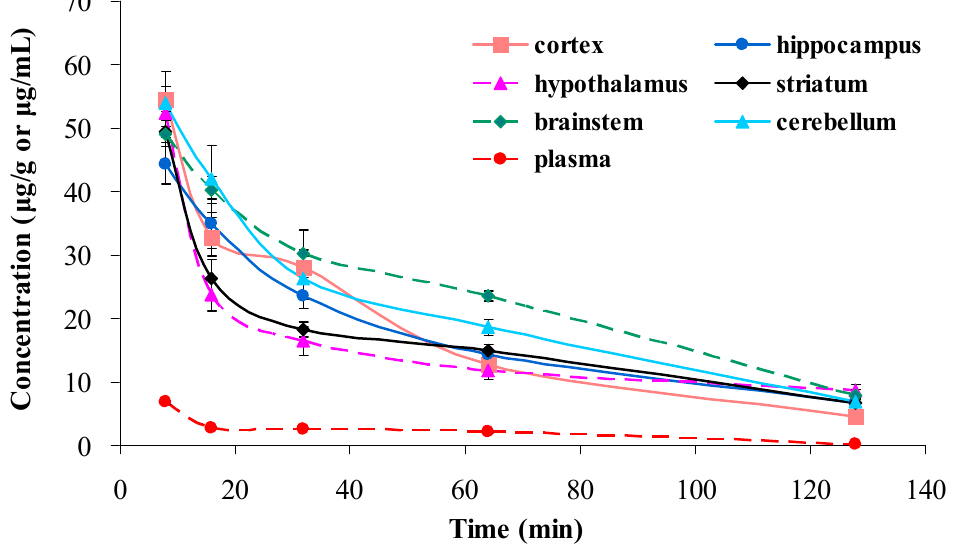
Figure 3. Concentration-time profiles of DDIE in cerebral nuclei and plasma after intravenous administration of DDIE at a single dose of 40 mg/kg to rats ( n = 5). The units of DDIE in cerebral nuclei and plasma are μ g/g and μ g/mL, respectively.